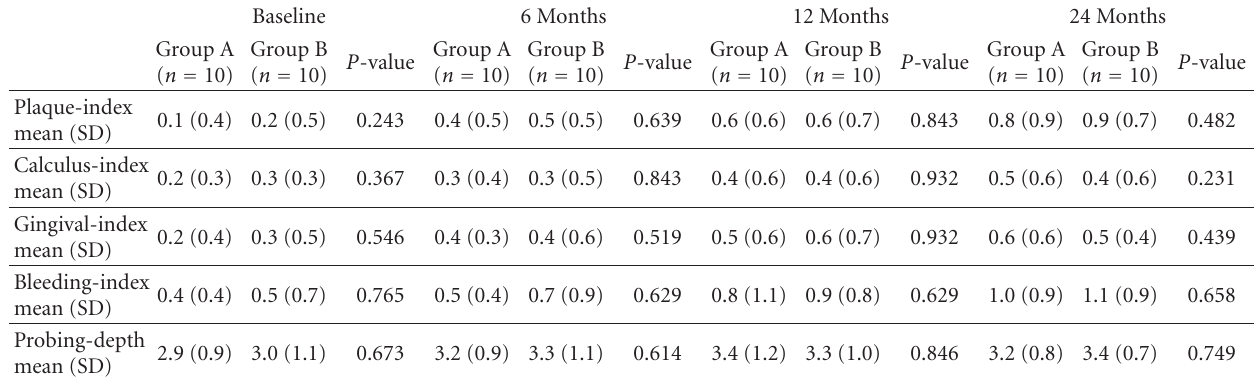
Table 3: Peri-implant parameters (Means and SDs) at all recall examinations.